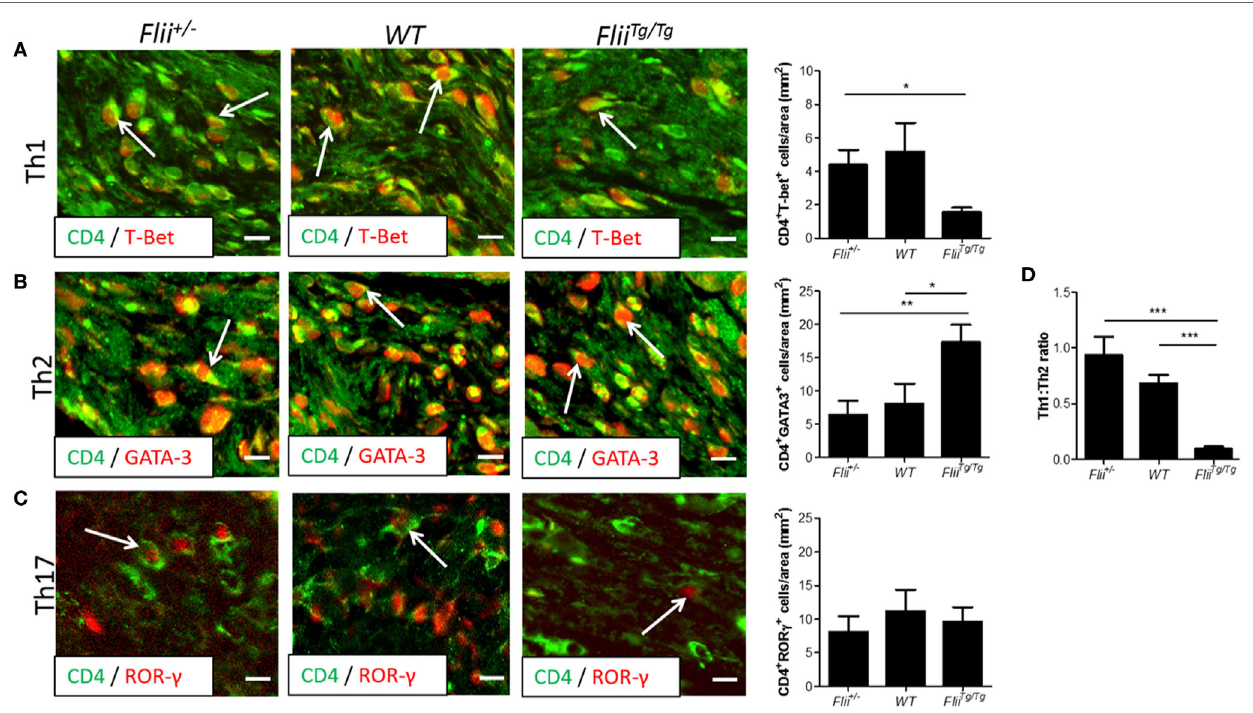
FigUre 5 | Mice with increased Flii expression exhibit increased Th2 cell numbers within OVA-induced atopic dermatitis (AD) skin-like lesions. (a) Representative images and graphical analysis of Th1 (CD4 + T-bet + ) cell numbers in AD skin-like lesions within Flii + / − , WT, and Flii Tg/Tg mice. (B) Representative images and graphical analysis of Th2 (CD4 + GATA-3 + ) cell numbers in AD skin-like lesions within Flii + / − , WT, and Flii Tg/Tg mice. (c) Representative images and graphical analysis of Th17 (CD4 + ROR γ + ) cell numbers in AD skin-like lesions within Flii + / − , WT, and Flii Tg/Tg mice. (D) Ratio of Th1 to Th2 cells within AD skin-like lesions of Flii + / − , WT, and Flii Tg/Tg mice. Magnification 4 × scale bar 200 µm. n = 6. Mean ± SEM. * <